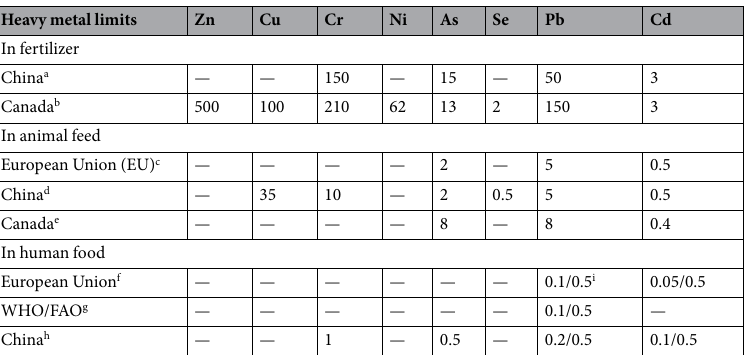
Comparing the concentrations of heavy metals in the harvested maggots used in the chicken feed in this study to the standards for animal feed in China, Canada, and the European Union (Table 2), the contents of Cu, Cr, As, Cd and Pb in the maggots met the standards in China, while the contents of Se and Cd exceeded the standards in China (Se < 0.5 mg/kg) 50–54 . The results indicated that the levels of heavy metals among the harvested maggots were distinctly lower than in the living environment, and regarding these five metals, these maggots would be safe to be used as feed. Due to the contents in the chicken faeces (Fig. 3), we can conclude that the metabolic capacities of different heavy metals in chickens are diverse. Our results indicated that chickens have better excretion capacity for Cd, Se, Cu and Pb, with higher excretions in faeces with greater contaminant intake. On the other hand, the ability of